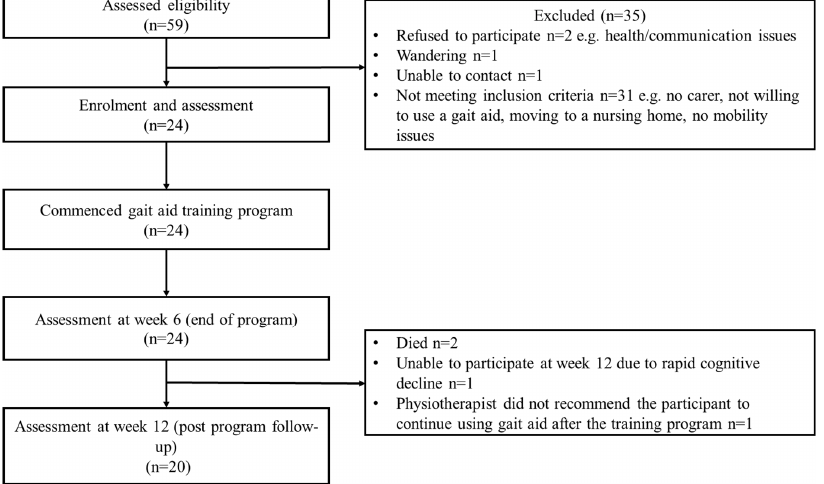
Figure 1. Participant flow chart. Table 1. Participant demographics/characteristics at week